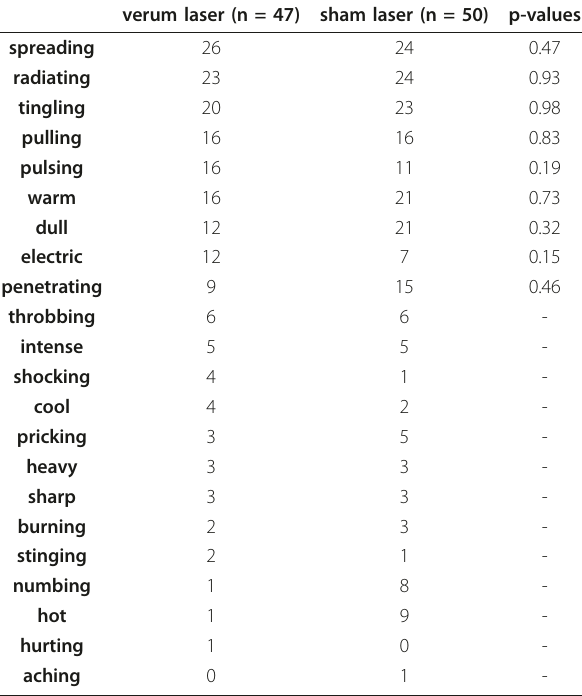
Table 3 Absolute frequency of adjective used to describe perceptions during the acupuncture